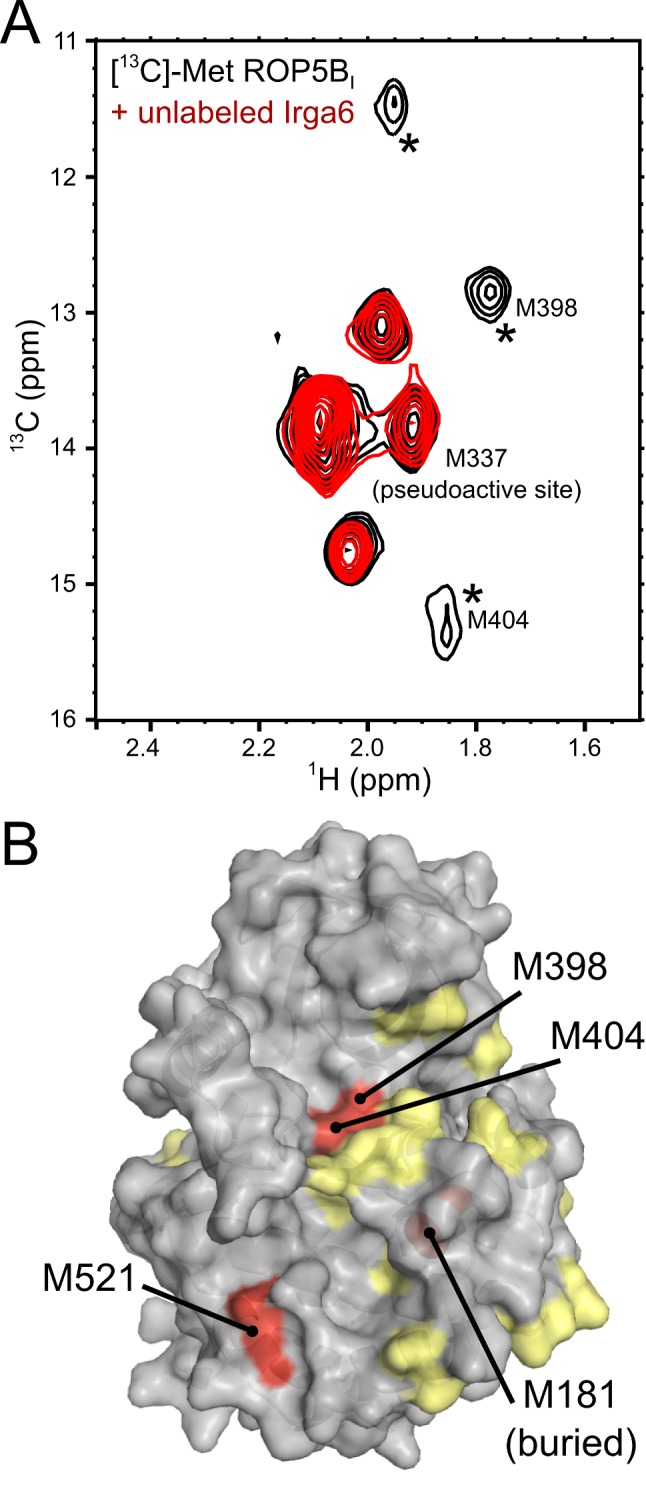
Irga6 binds ROP5 distal from the pseudoactive site.(A) HSQC spectra of [13C]-Met labeled ROP5BI in the absence (black) or presence (red) of unlabeled Irga6. Peaks that are broadened upon addition of Irga6 are starred. Peaks that have been assigned by mutagenesis (see Figure S2) are noted. (B) A surface representation of the rear face of the ROP5BI structure, where surface exposed methionines are highlighted in red and the buried methionine M181 is shown in red spheres. Polymorphic residues are highlighted in yellow.